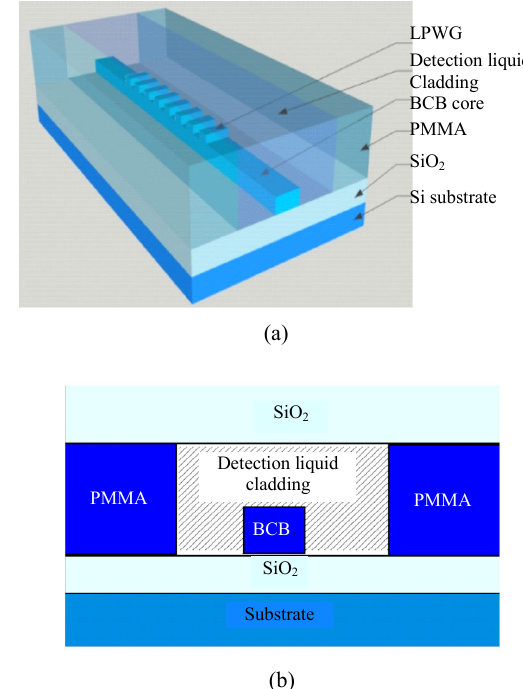
Fig. 1 Schematic diagram of (a) three-dimensional structure and (b) cross-section of the LPWG based